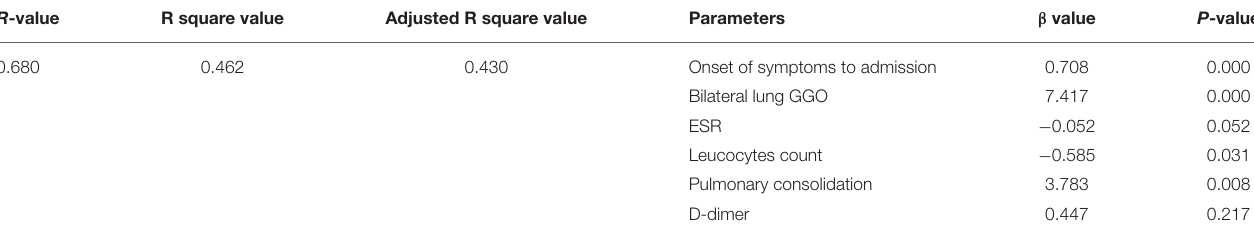
TABLE 6 | Relevant factors of the length of symptoms relief.